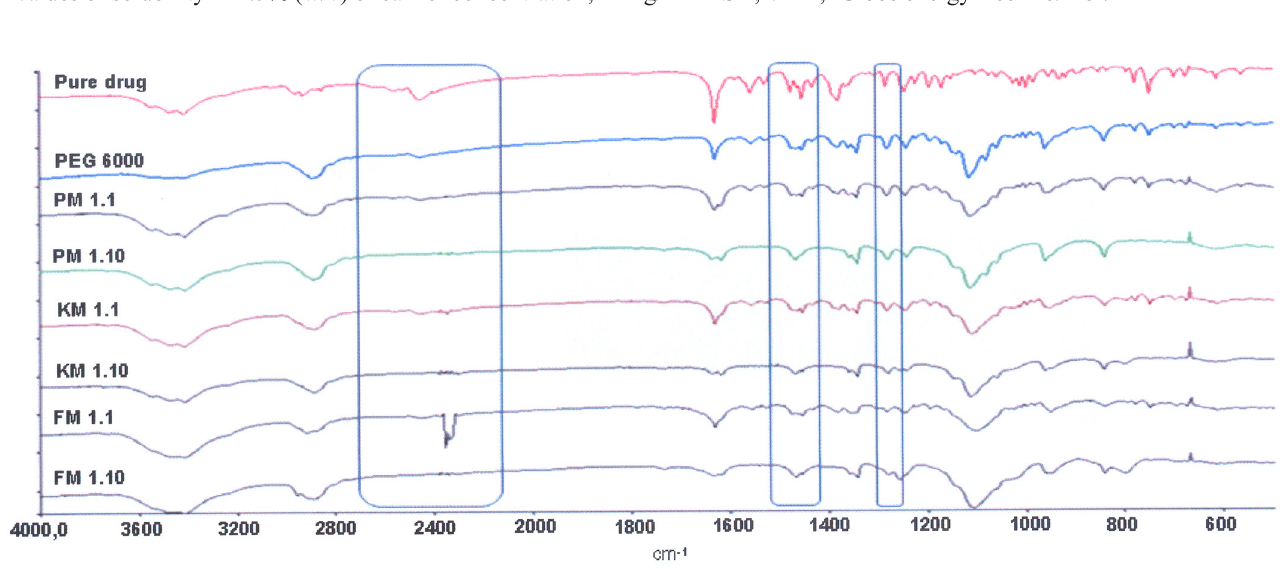
FIGURE 2 - FT-IR of the AMH pure (A), PEG 6000 (B), physical mixture, kneading method and fusion